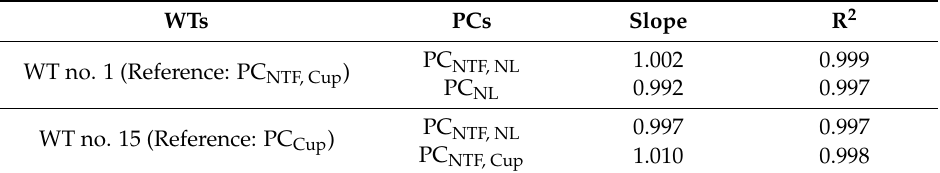
Table 6. Results from the two-parametric linear regression analysis between power curves. WTs PCs Slope R 2 PC NTF, NL 1.002 0.999 WT no. 1 (Reference: PC NTF, Cup ) PC NL 0.992 0.997 PC NTF, NL 0.997 0.997 PC NTF, Cup 1.010